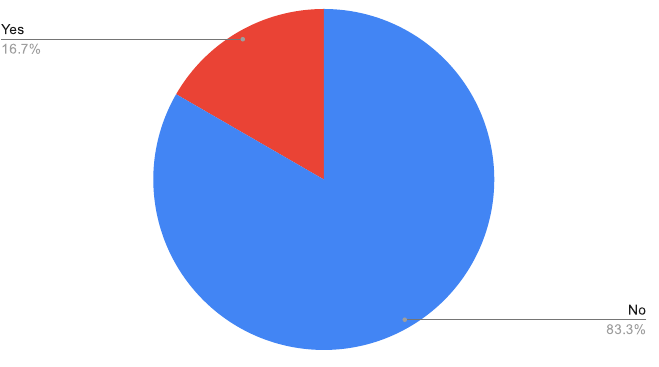
Figure 5. Exposure to Light Before Experiment.